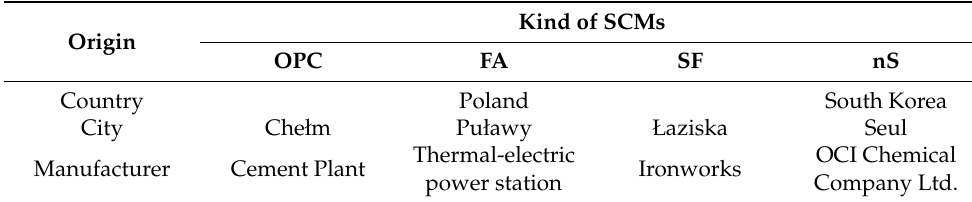
Table 3. The origin of SCMs used.